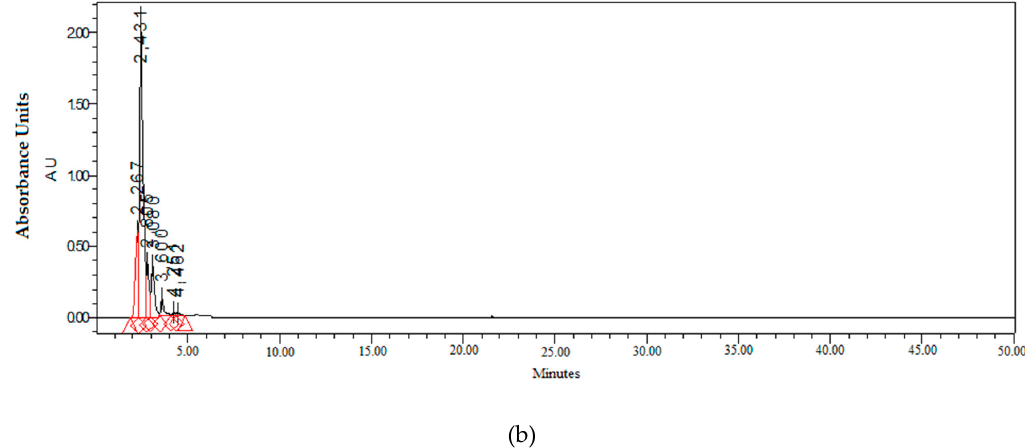
Figure 2. Chromatogram profiles of the amino acids ( a ) and polyphenols ( b ) detected in the TX fertilizer.